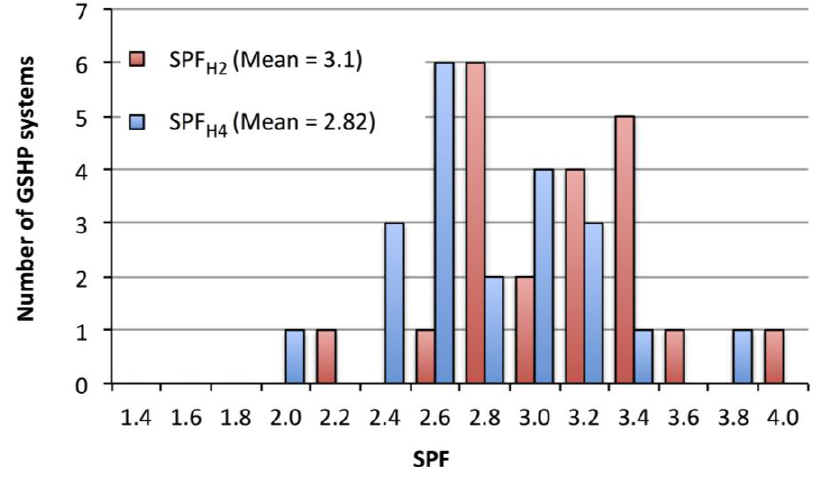
Figure 6. Seasonal Performance Factor data (SPF the national field trial (after implementation of improvement measures). Data from